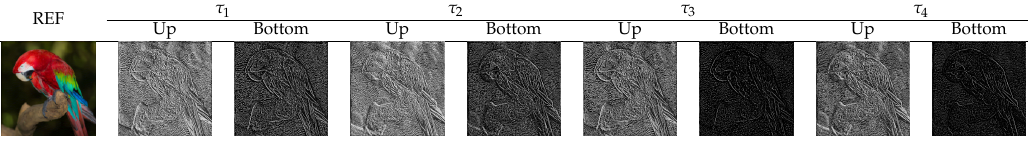
Figure 17. The reference image and its upper and lower patterns generated using the Local Ternary Pattern (LTP) descriptor with four different threshold